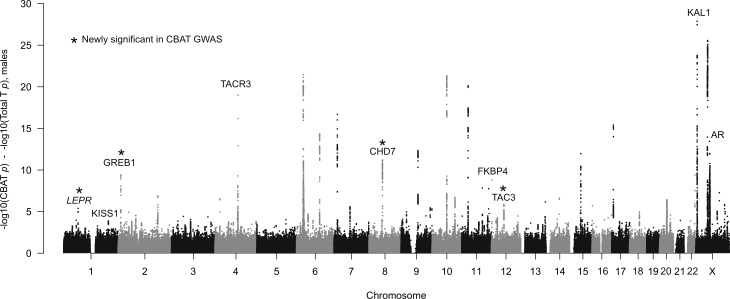
Manhattan plot of difference in significance of assocation comparing GWAS of calculated bioavailable testosterone (CBAT) to total testosterone.Only points more significant in CBAT GWAS (i.e. positive values on y-axis) are shown. Genes with known roles in the HPG axis are annotated.